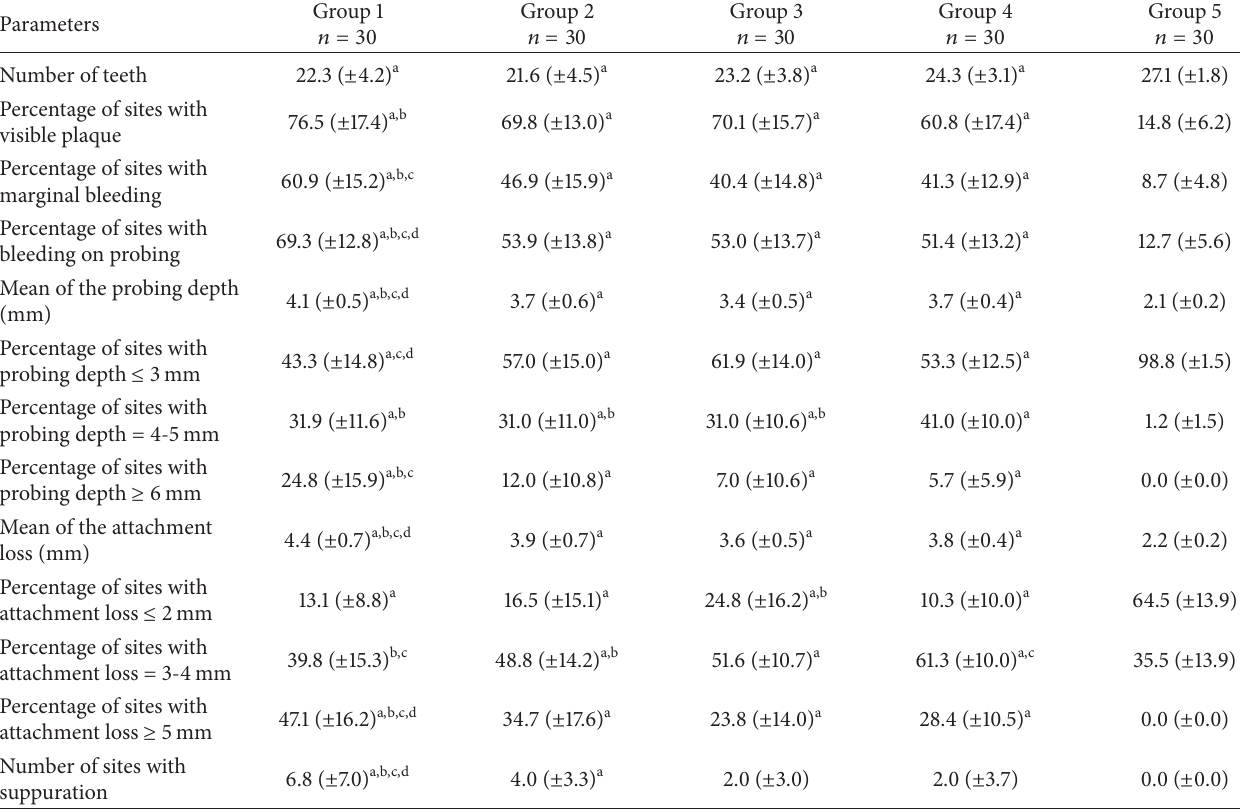
Table 1: Periodontal parameters of the sample (mean ±